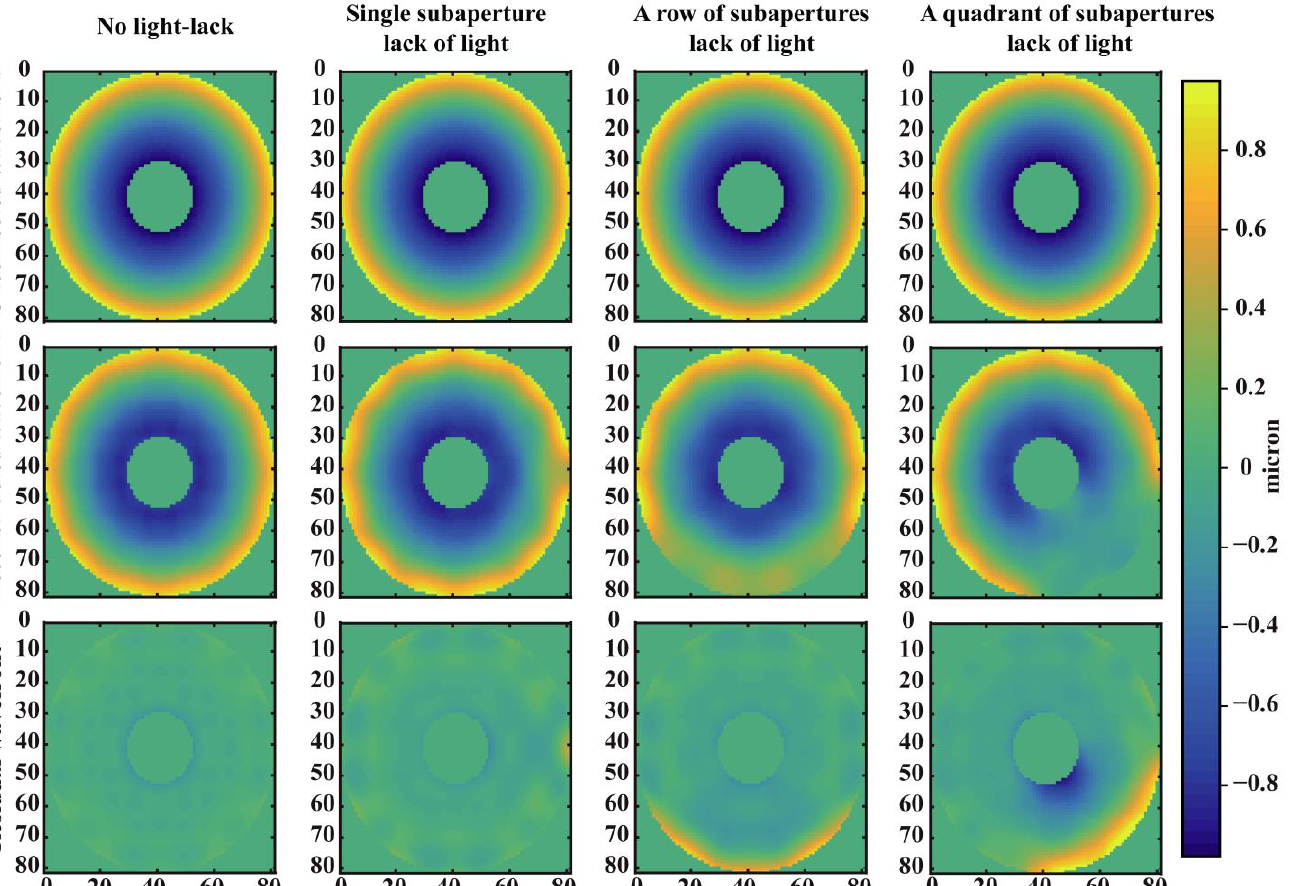
Figure 9. The statistical defocus aberration at the pupil of the 1.2 m telescope. ( a , b ).